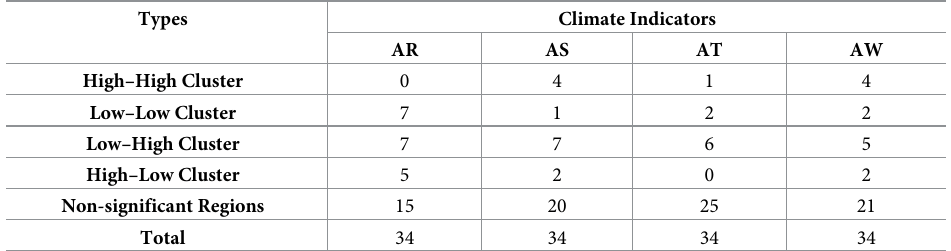
Table 1. Spatial cluster of the rural population distribution and climatic